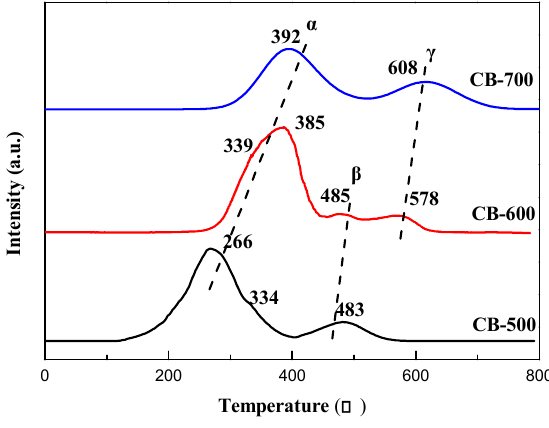
Figure 5. H 2 -TPR profiles of CuO-Bi 2 O 3 catalysts.